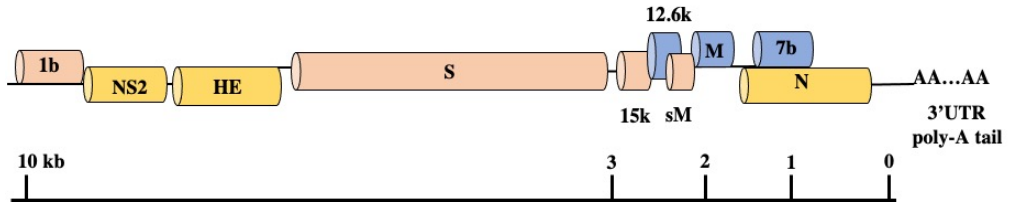
Figure 5. Genome structure and ORFs in the 3 ′ end 9.8kb of SDAV viral genome. Own work based on [43].